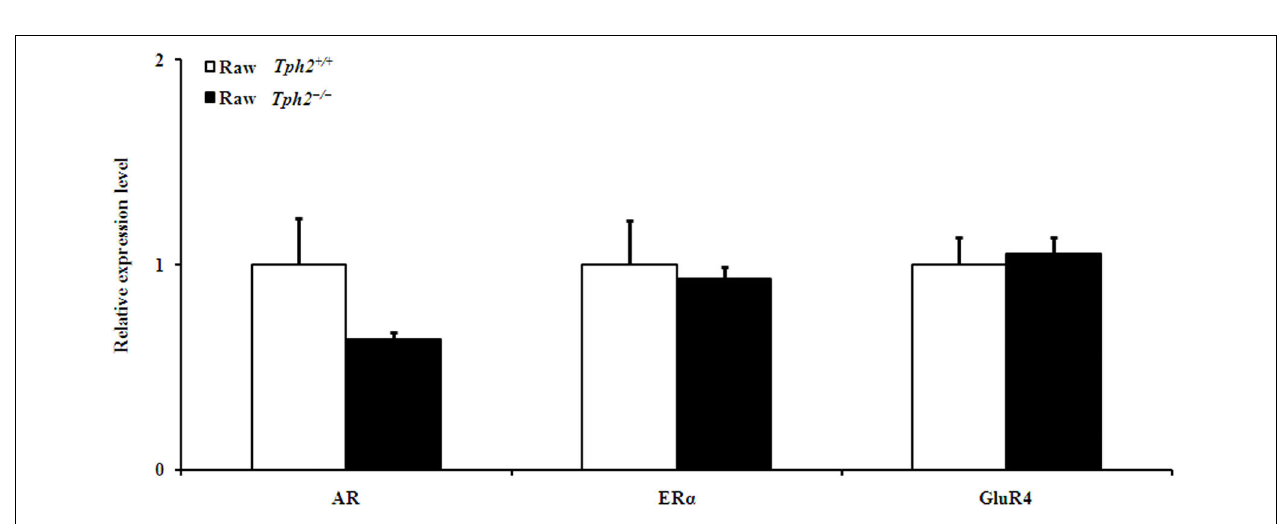
the raw Tph2 − / − male mice, n = 6). The data were analyzed by independent-samples t -test, no significant differences were showed between